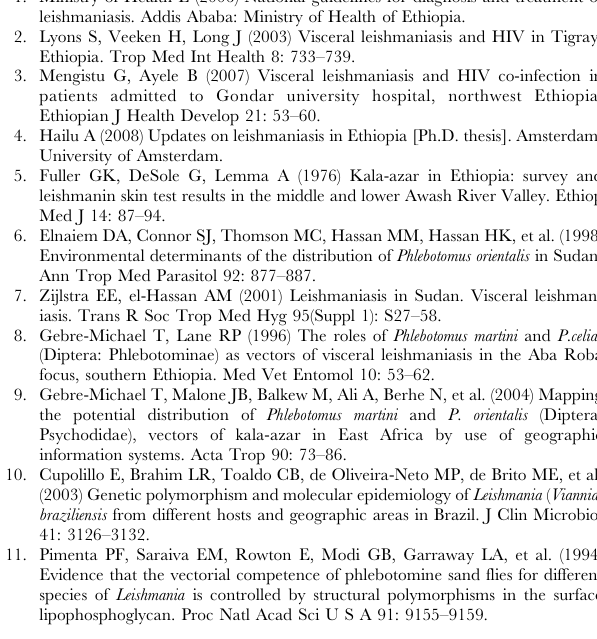
Table S2 Microsatellite profiles of putative hybrid strains and their corresponding hypothetical parents for the six microsatellite loci.